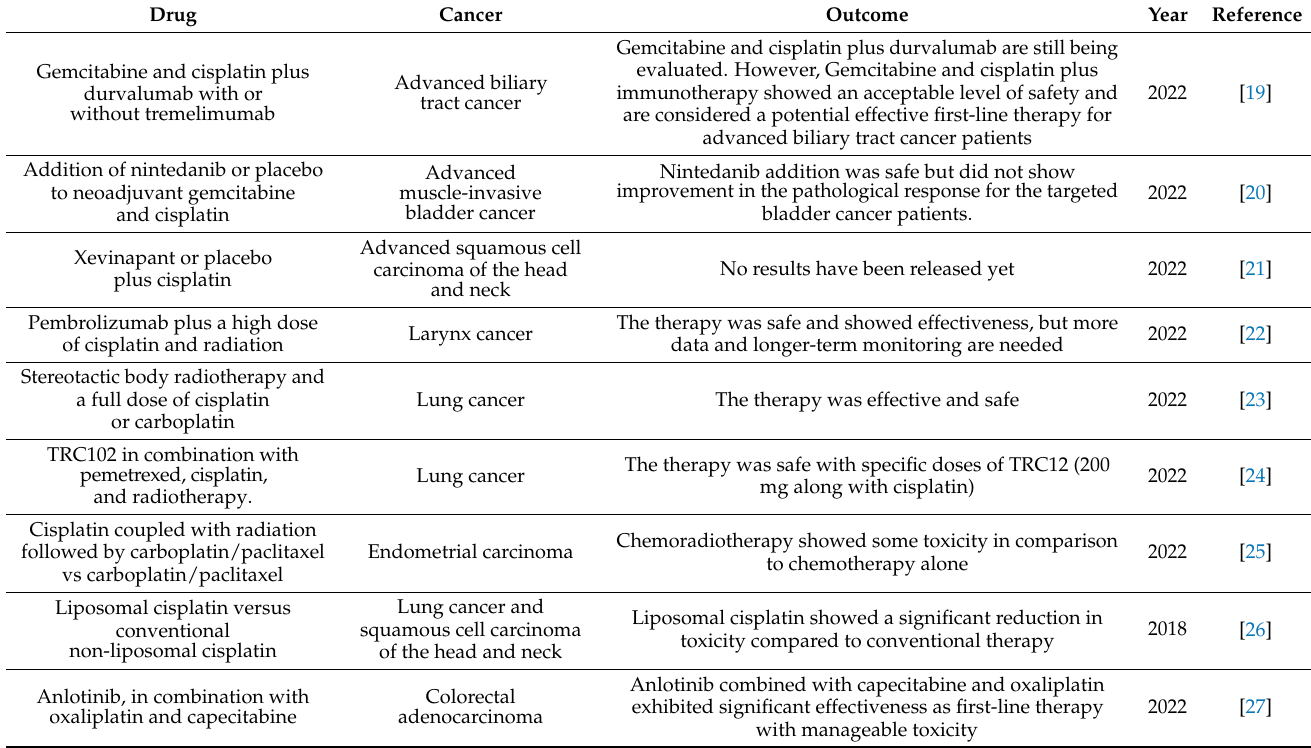
Table 1. Recent studies on the combination of platinum derivatives with other